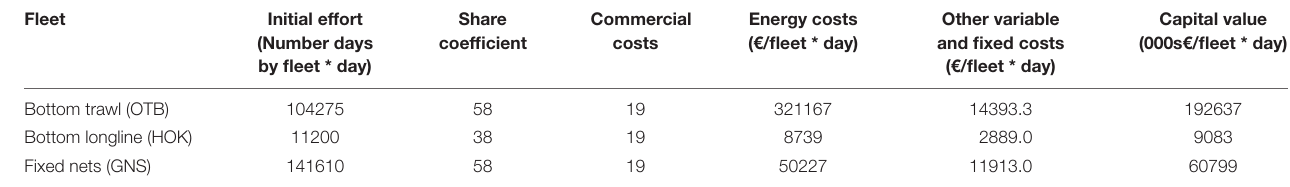
TABLE 4 | Economic parameters of the three fleets assessed for bioeconomic simulation of the GSA06.